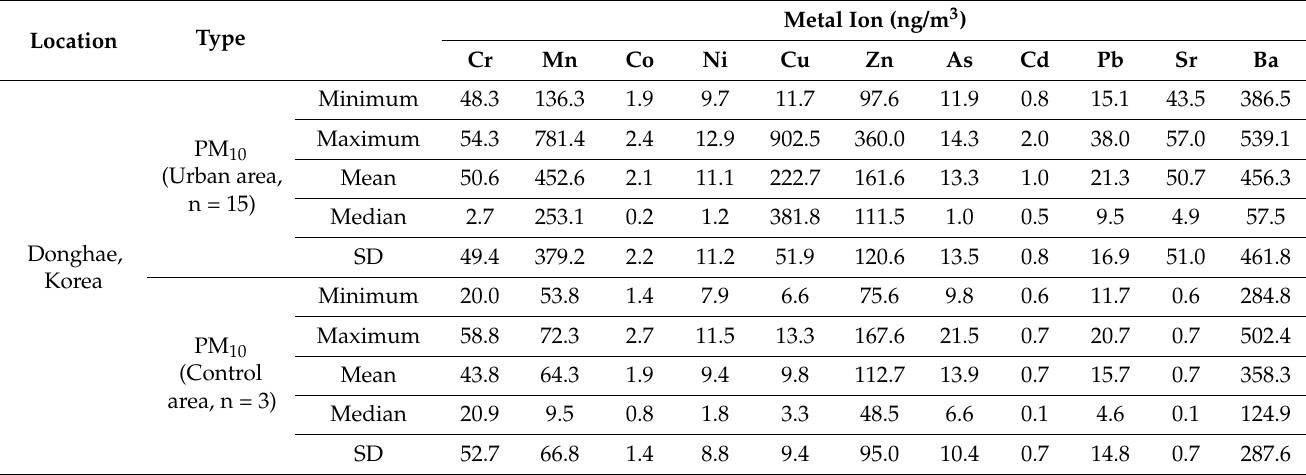
Table 2. The concentration of metal ion of PM 10 samples in the study